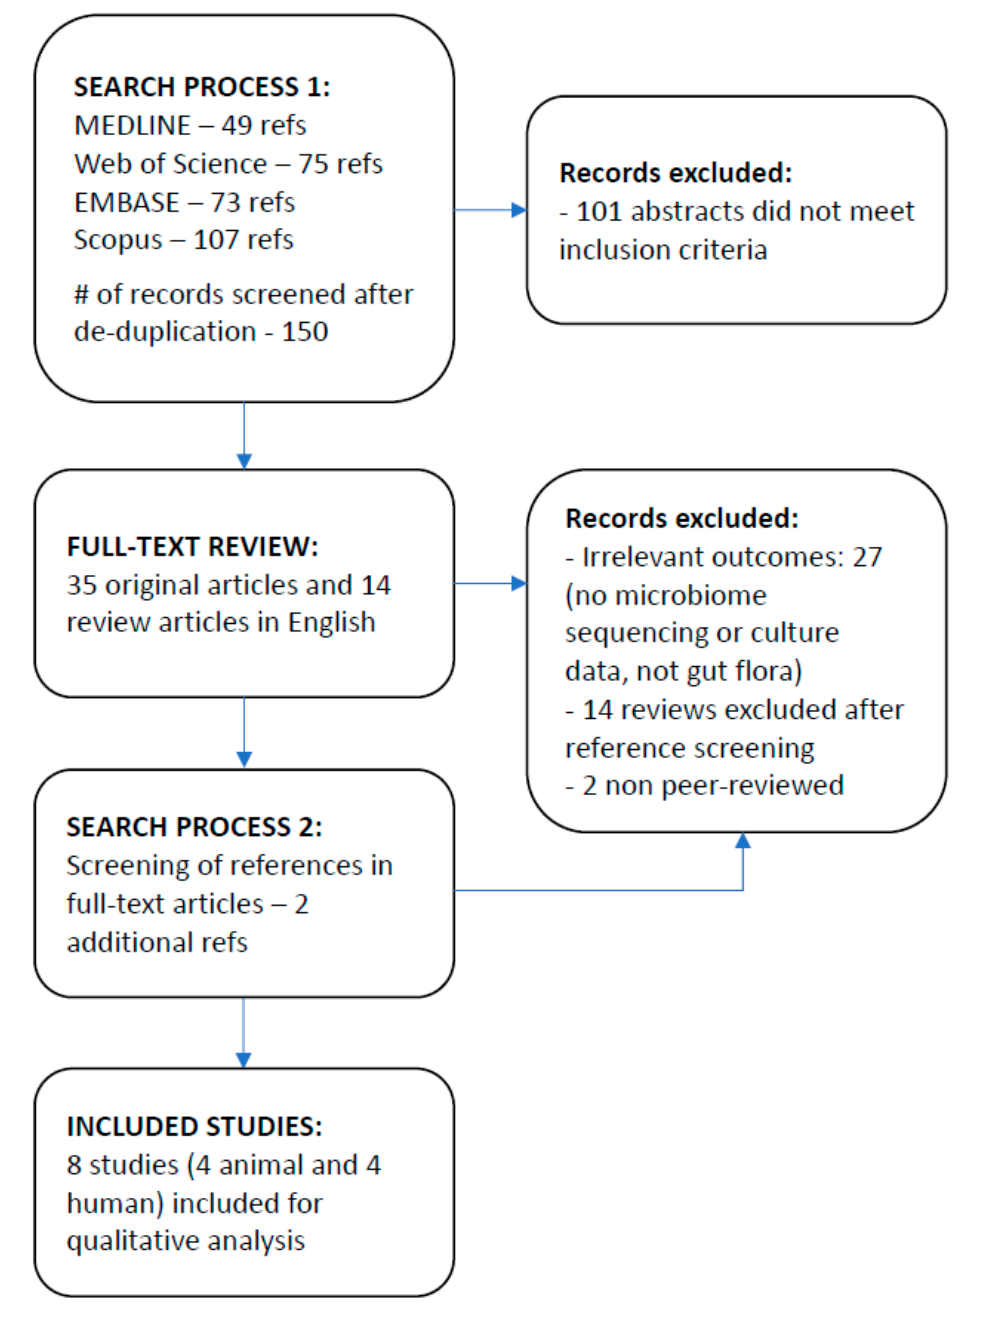
Figure 1. Study flow diagram.